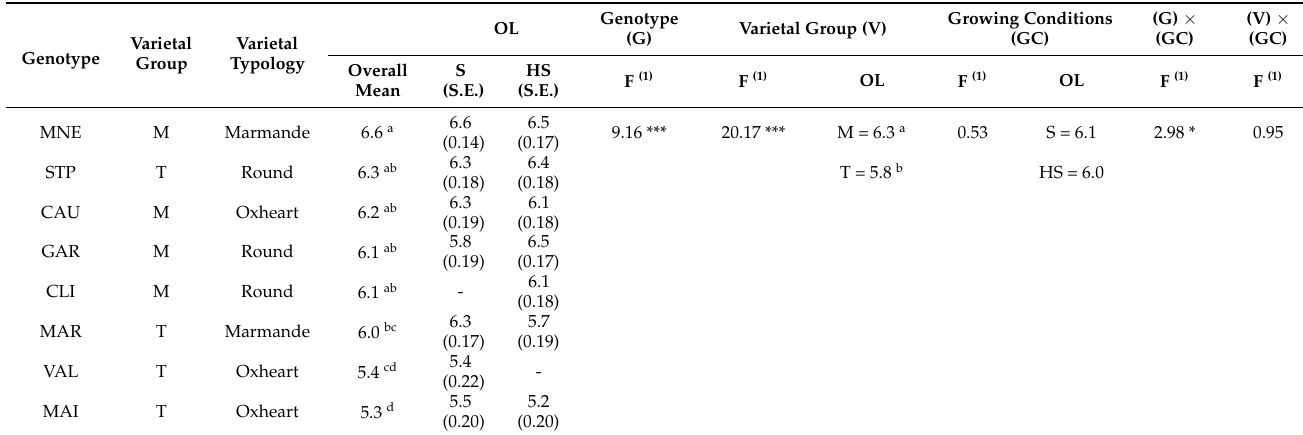
Table 3. Analysis of variance and mean overall liking (OL) scores ( n = 100) of tomato samples harvested at red ripe stage in France (9-point hedonic